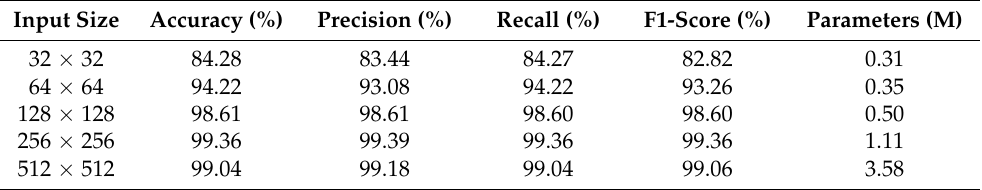
Table 5. Performance of the model with different malware images.